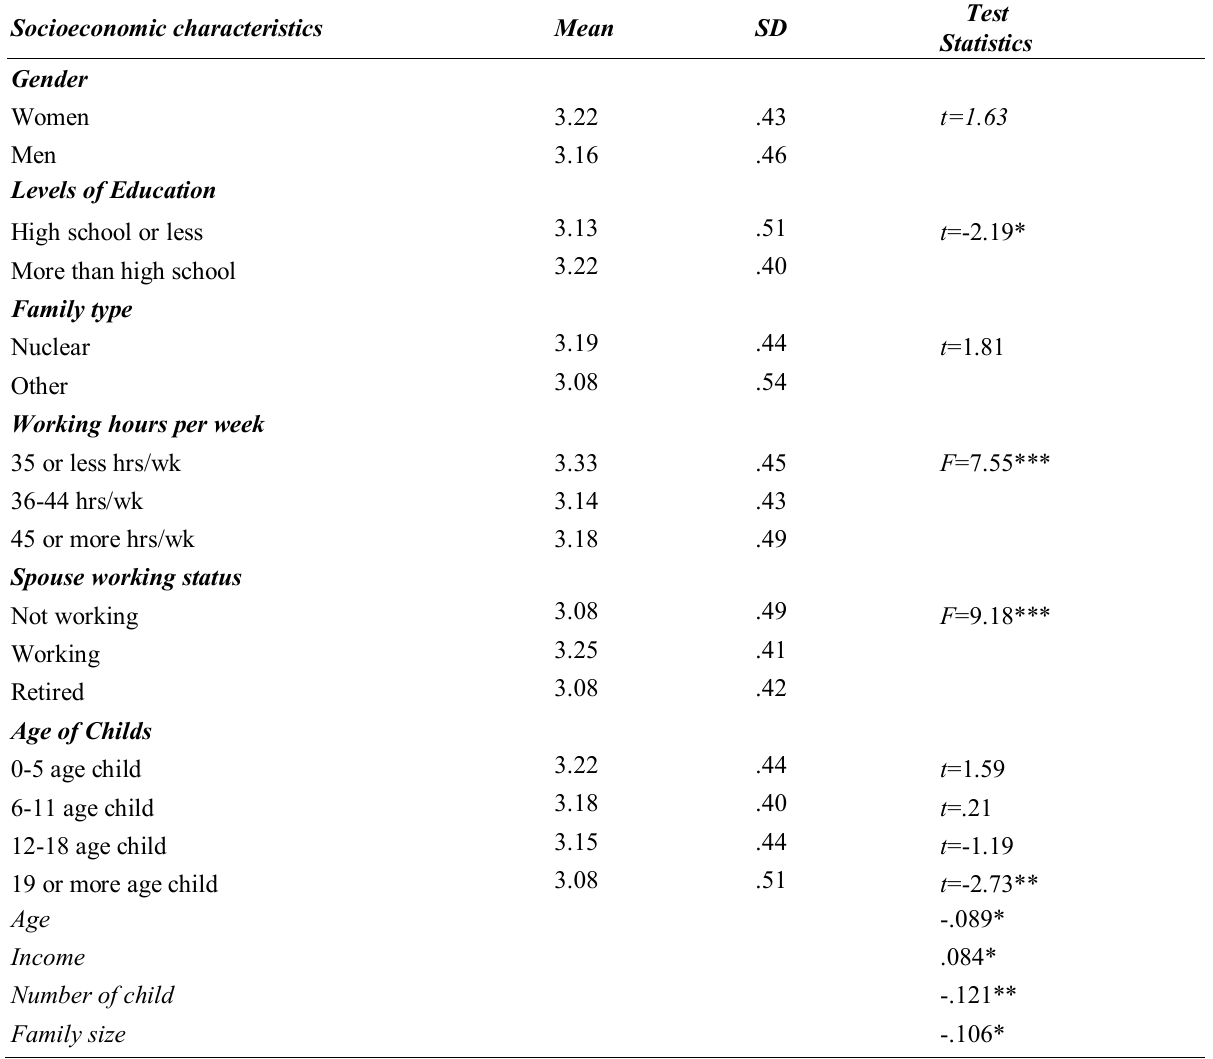
Tabel 2. Bivariate Analysis Results of Family Functioning Style Scale